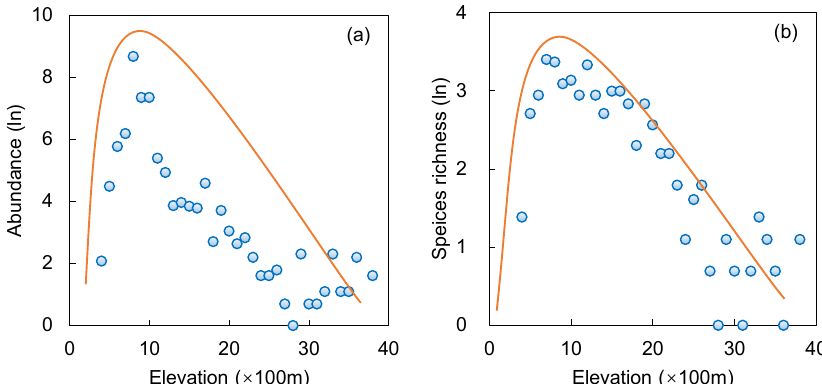
Figure 1. Vertical distribution patterns of the venerable trees in Sichuan in relation to: ( a ) tree abundance, and ( b ) species richness. The scatter points were fitted using a linear function.